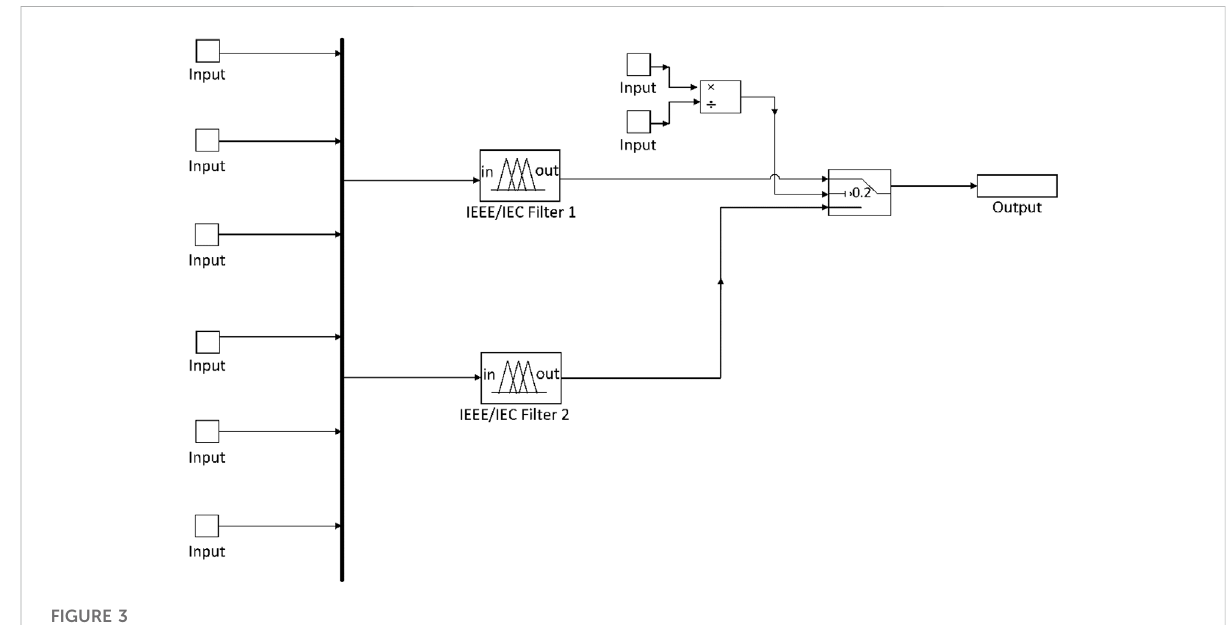
FIGURE 3 Fuzzy sublogic based on dissolved gas analysis.